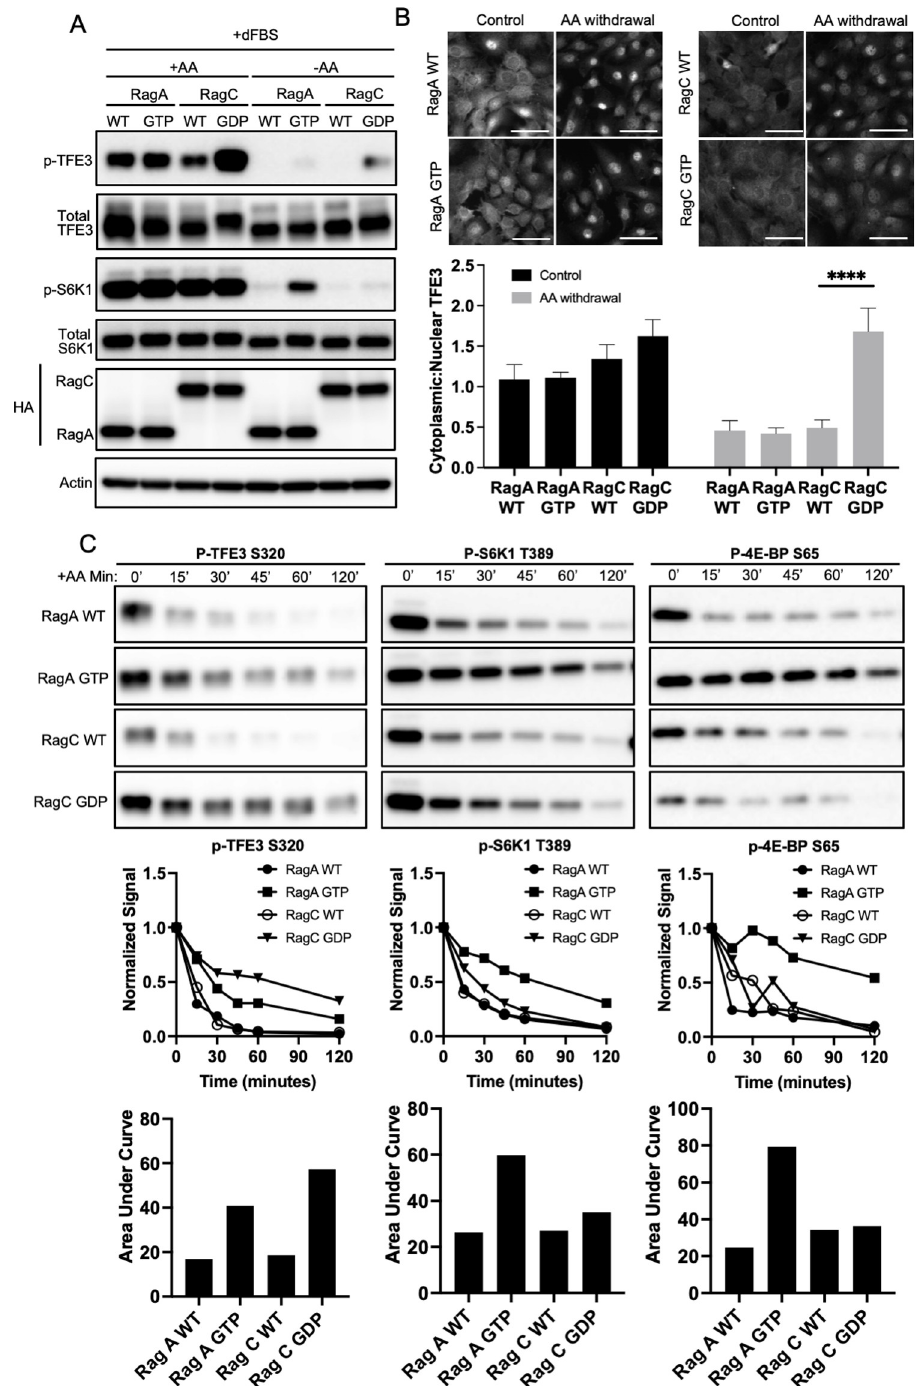
Fig 2. RagC, but not RagA, promotes TFE3 phosphorylation in response to AAs. (A, B) C2C12 cells expressing HA-tagged WT or constitutive active RagA (GTP) or RagC (GDP) were switched from complete medium to media lacking AAs, as indicated, followed by immunoblotting for TFE3, phospho-TFE3, S6K, phospho-S6K, and HA (A) or immunohistochemistry for subcellular localization of TFE3 (B). Quantification of cytoplasmic-to-nuclear ratio of TFE3 is shown below the images. Scale bar: 20 μ m, ���� p < 0.0001 by Student t test. (C) The same cells as in A, subjected to a time course after withdrawal of AAs, followed by immunoblotting for phospho-TFE3, phospho-4EBP, and phospho-S6K. Densitometric quantification is shown below. The data underlying all the graphs shown in the figure is included in S1 Data. AA, amino acid; dFBS, dialyzed FBS; WT, wild type.